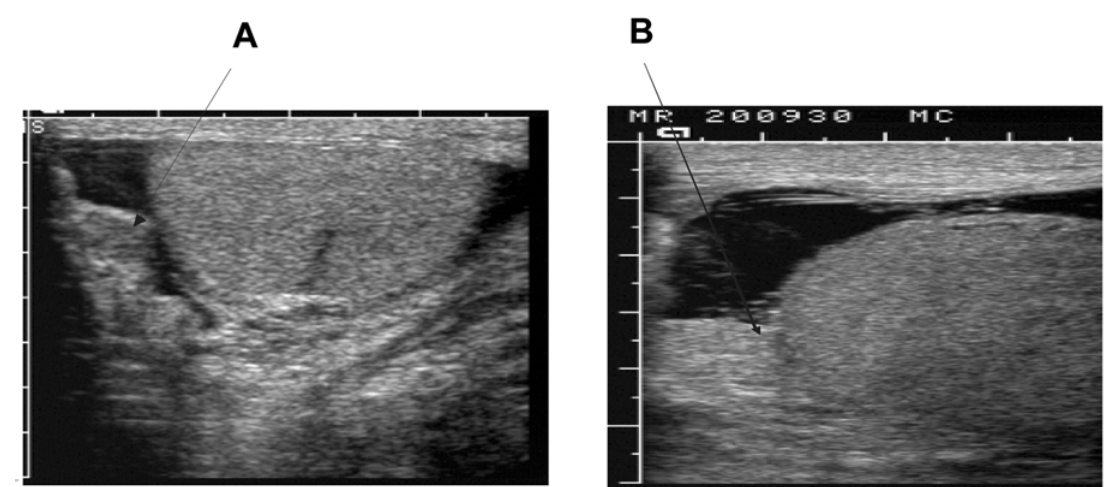
Figure 2 – Testicular ultrasound showing a normal right epididymis (A) and an enlarged and thickened left epididymis